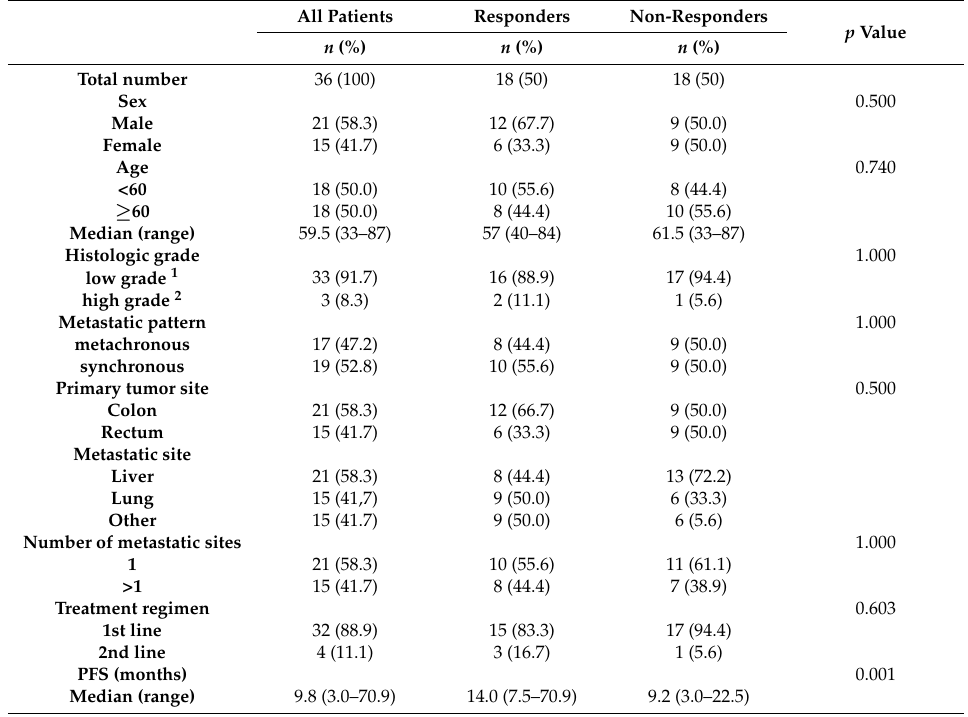
Table 1. Patient